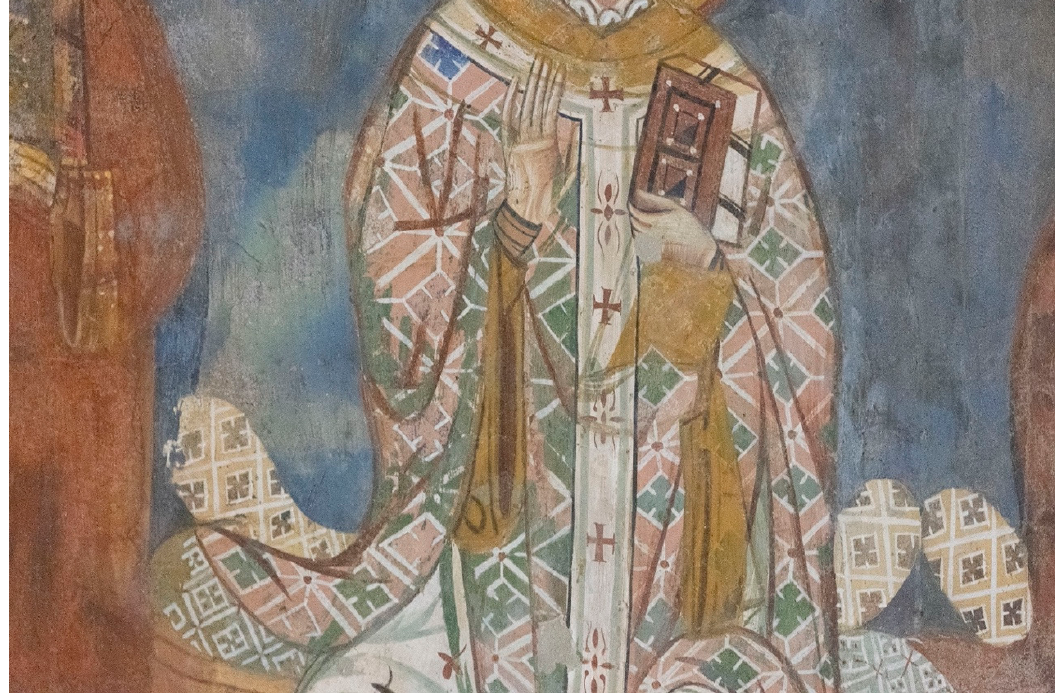
Figure 12. Sacro Speco, Subiaco (Italy), Lower Church. Fresco. Lunette, particular of St. Nicholas. Photo: Davide Giannetti.